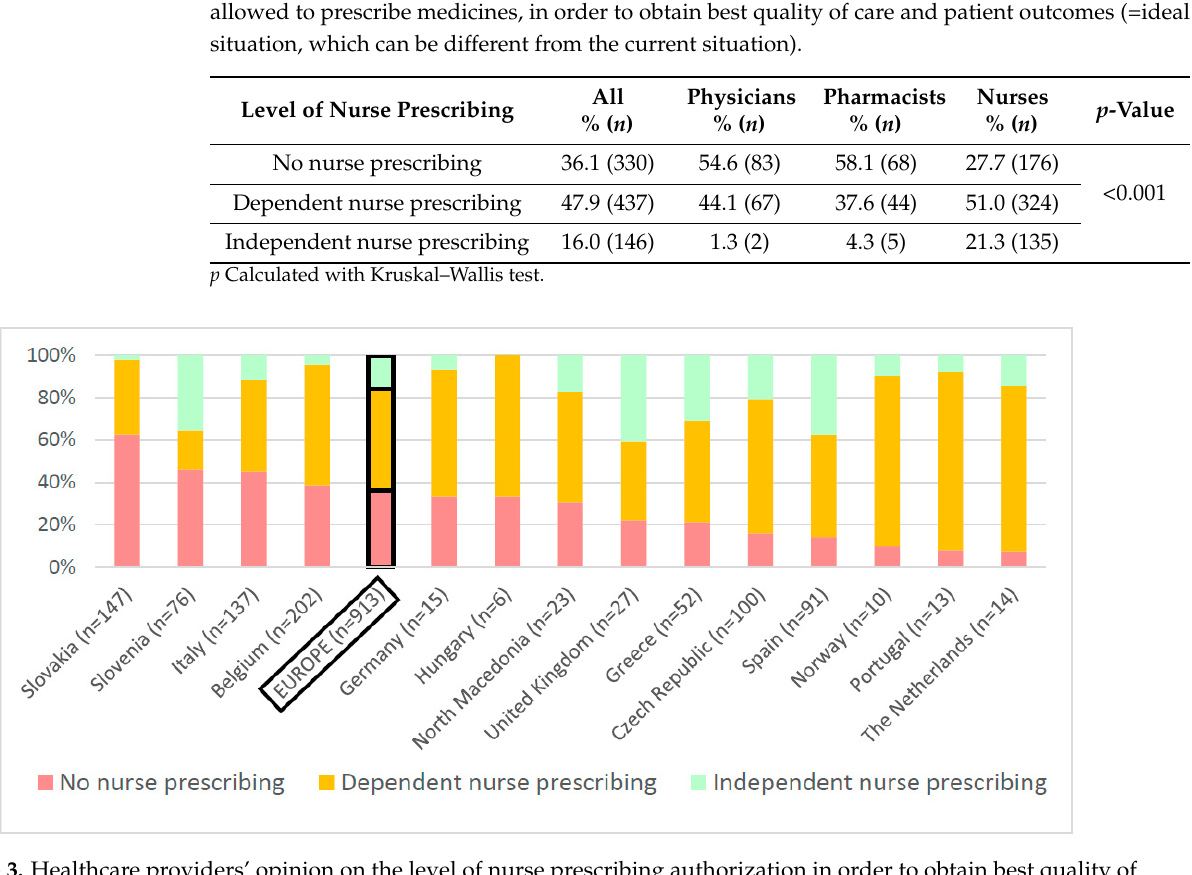
Figure 3 . Healthcare providers’ opinion on the level of nurse prescribing authorization in order to obtain best quality of care and patient outcomes in 14 countries ( n = 913; p < 0.001).